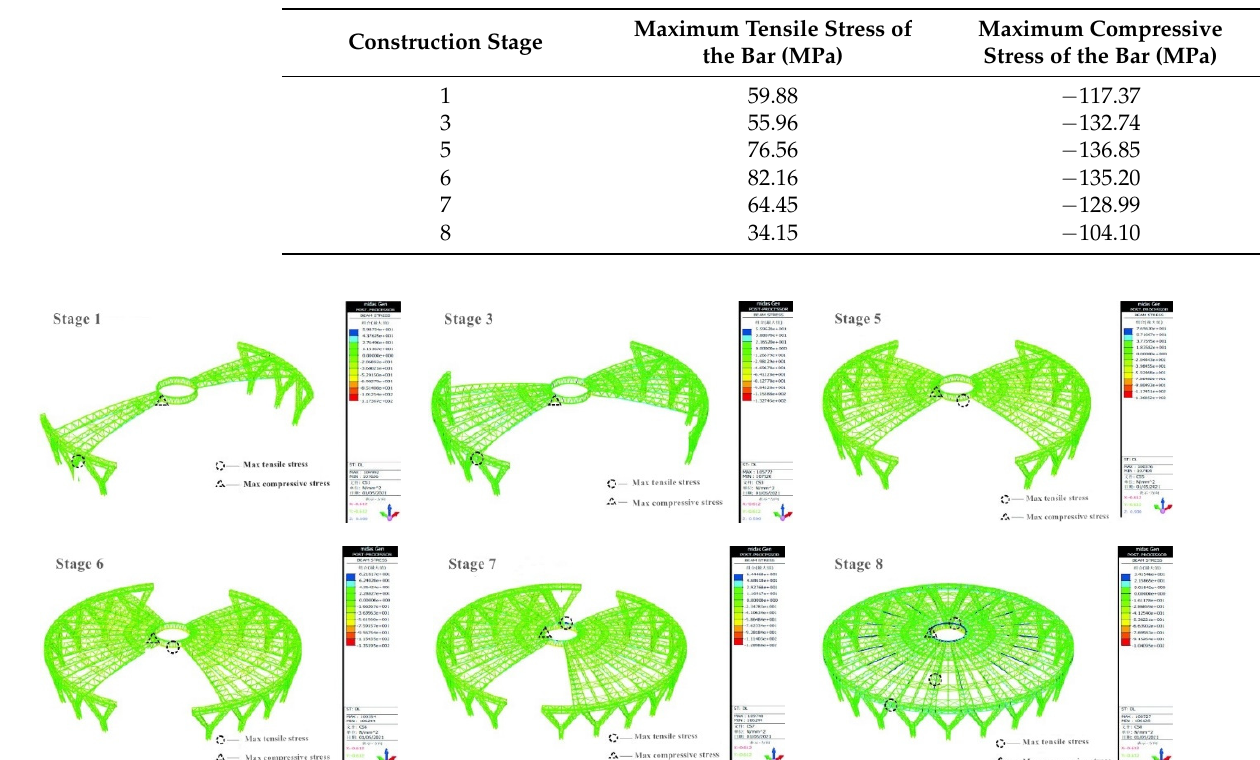
Table 1. Maximum stress values during construction from modeling.